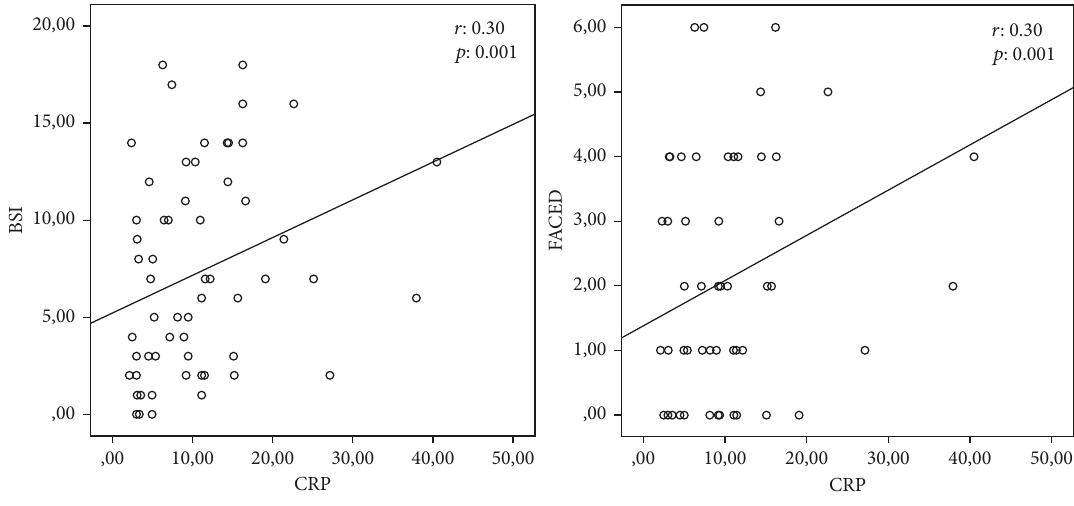
Figure 1: Correlation FACED and BSI scores with CRP levels. Table 4: Correlation coefficients and p values for FACED and BSI scores and study variables.